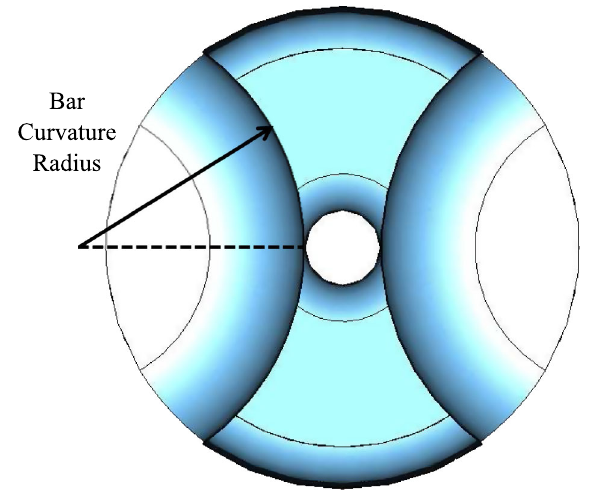
FIG. 21. Design parameter of optimization for the parallel-bar design with bars merged onto cavity surface.